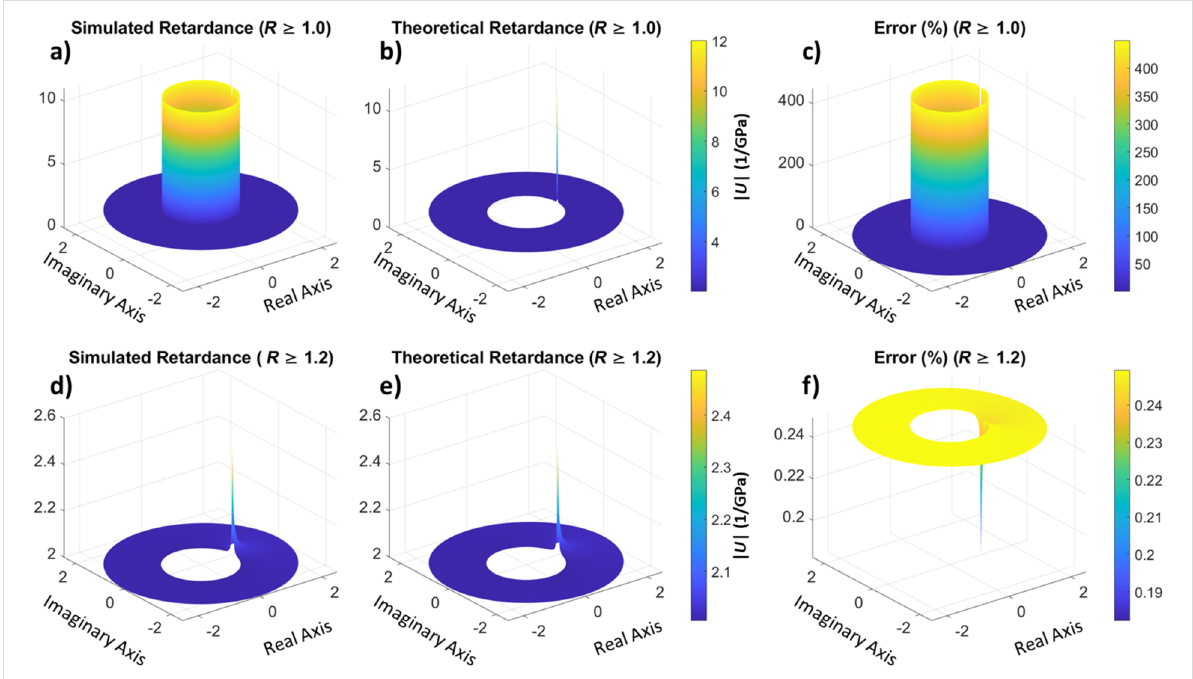
Figure 4: (a, d) Amplitude of the simulated retardance in the z -domain for a stress-strain experiment (plot d does not include the unit circle of the z -domain). (b, e) Retardance of the material calculated from the theoretical values (plot e does not include the unit circle of the z -domain). (c, f) Error between the simulated and theoretical retardance. The second-row figures contain the same information as the first-row figures, except that the data for R values smaller than 1.2 has been removed. A large error is observed around the unit circle, which is expected because the unit circle in the Z-transform represents the discrete Fourier transform and in this example we have used non-bounded, non-harmonic input and output [30]. The agreement between theory and simulation is good outside the unit circle ( R > 1), where every circle represents a modified discrete Fourier transform. The latter corresponds to oscillatory functions multiplied by a decaying (real) exponential function (as in a damped oscillation).